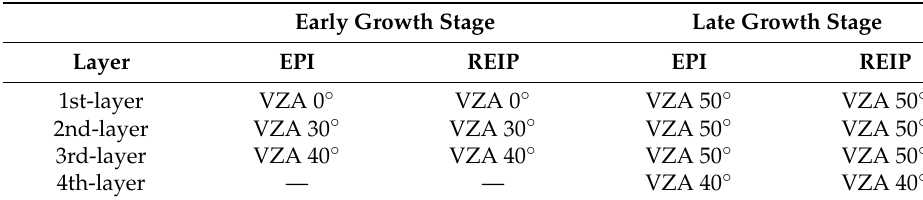
Table 4. Optimal selection of monitoring VZAs for different target layers.